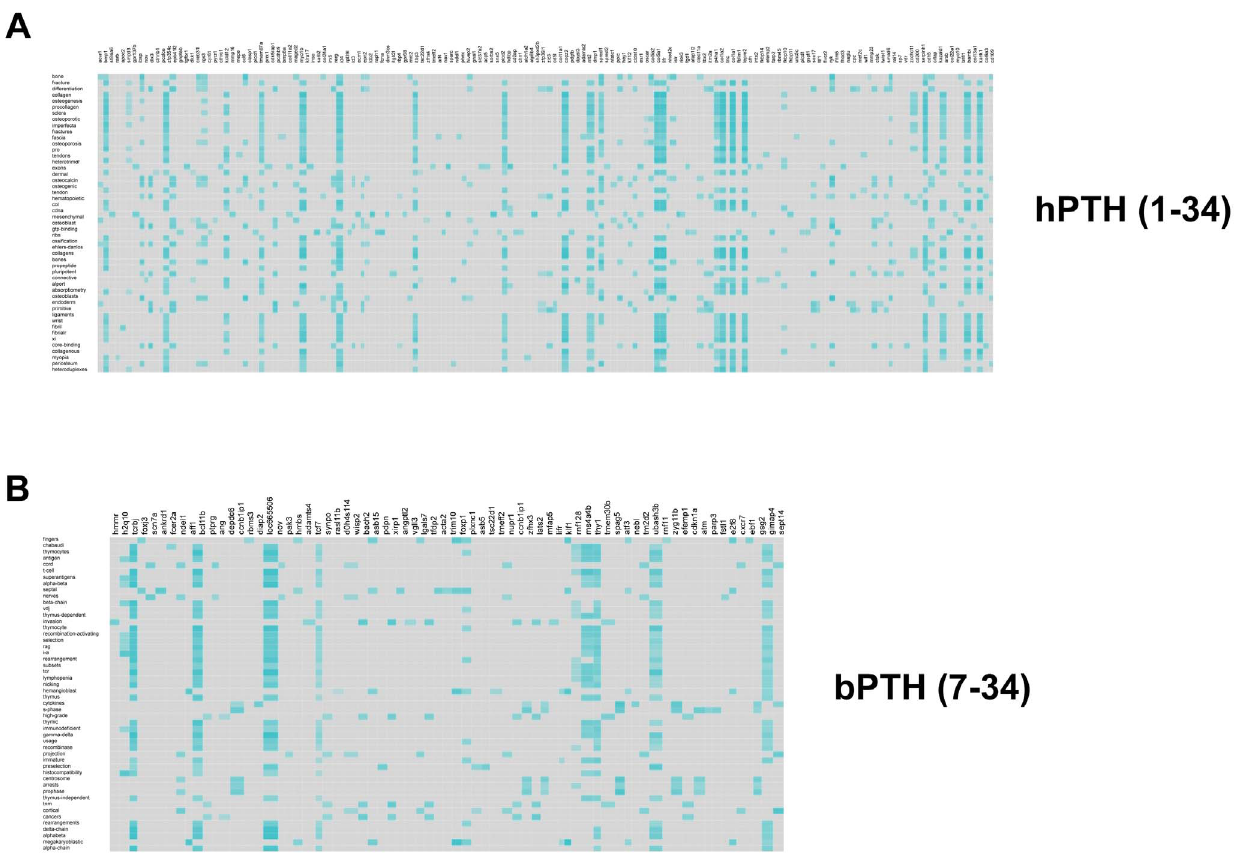
Figure 8. Textrous!- mediated individual processing output of compare-and-contrast large datasets. Individual processing heatmaps for hPTH (1–34)- and bPTH (7–34)-mediated transcriptomic activity in murine calvarial bone are demonstrated in panels (A) and (B) respectively. Teal- colored blocks indicate strongly-associated gene-word interactions in a intensity-sensitive manner, while grey blocks indicate no significant interaction.